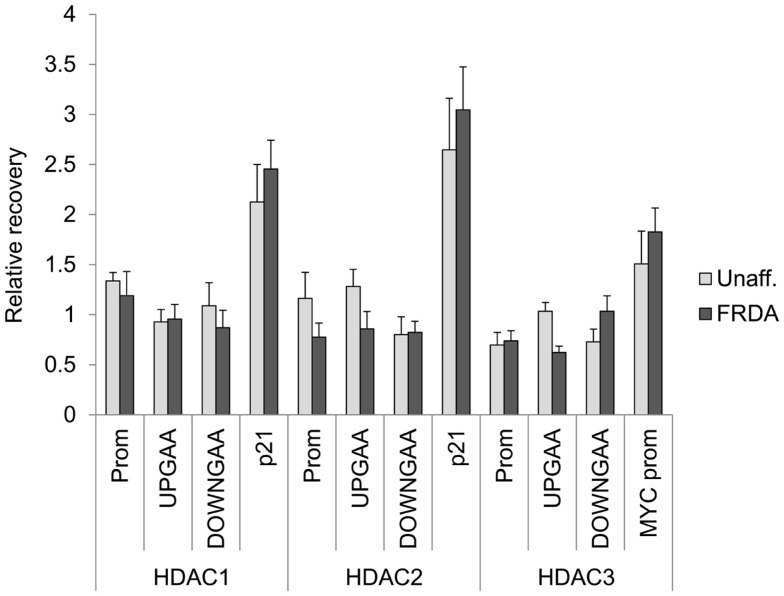
Class I HDACs are not detected on the FXN gene in neuronal cells. ChIP was performed on 16-day-old neurons with antibodies against HDAC1, HADC2, and HDAC3. The region of the promoter (Prom), upstream (UPGAA), and downstream (DOWNGAA) of the GAA•TCC repeats on the FXN gene were interrogated by qPCR. Data are plotted as enrichment over the DNA recovery of the GAPDH coding region. The recovery of CDKNA1 (p21) promoter and MYC promoter are shown as positive controls.